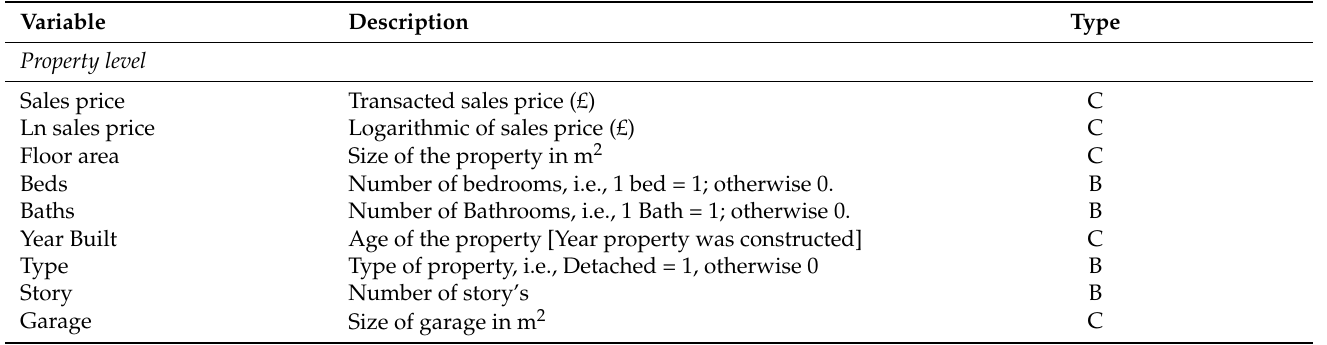
Table 1. Descriptions of property and neighbourhood variables